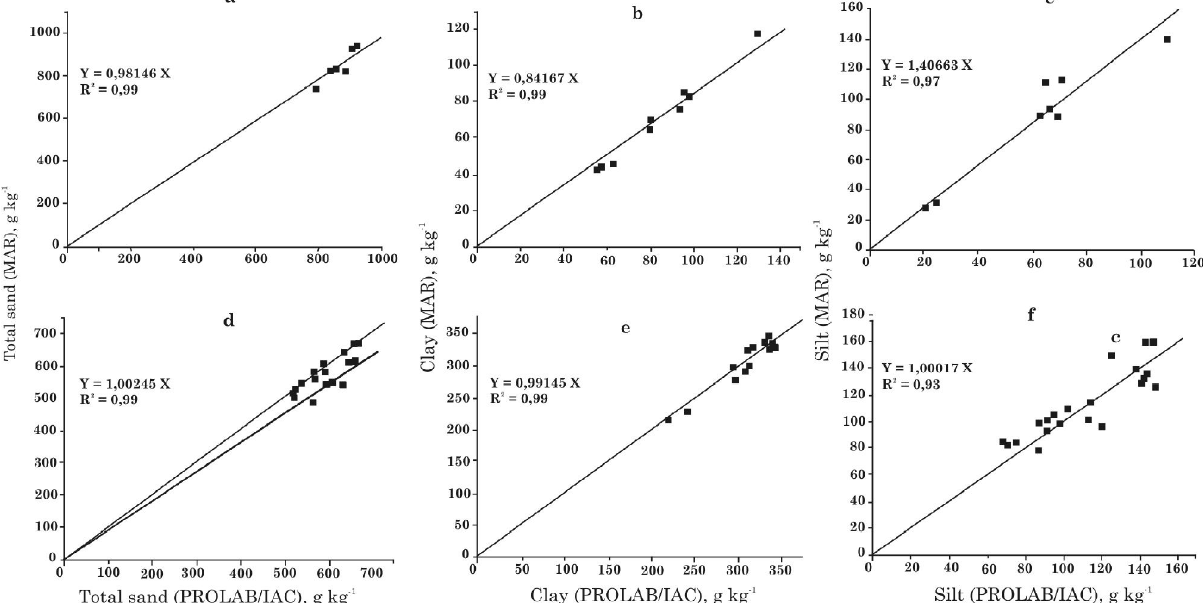
Figure 6. Dispersion charts for mean values of total sand, clay and silt extracted from the data of the Prolab/ IAC and results determined using the RSh for 9 Sandy soil samples ( a , b and c ) and for 21 Medium- textured soil samples ( d , e and f